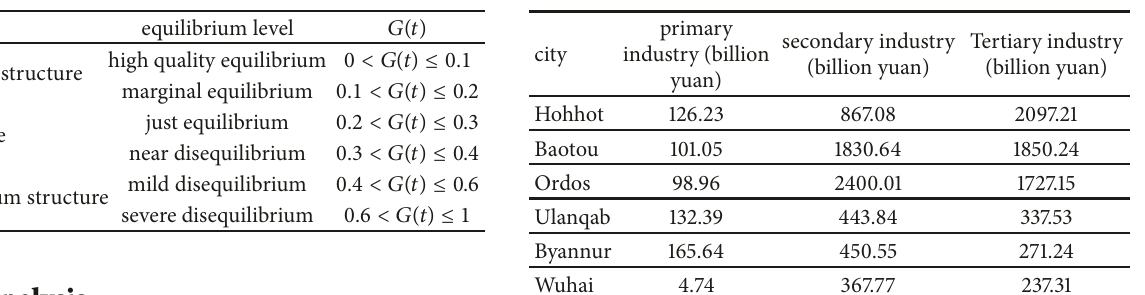
Table 2: Production value of three main industries in HuBaoOr urban agglomeration.